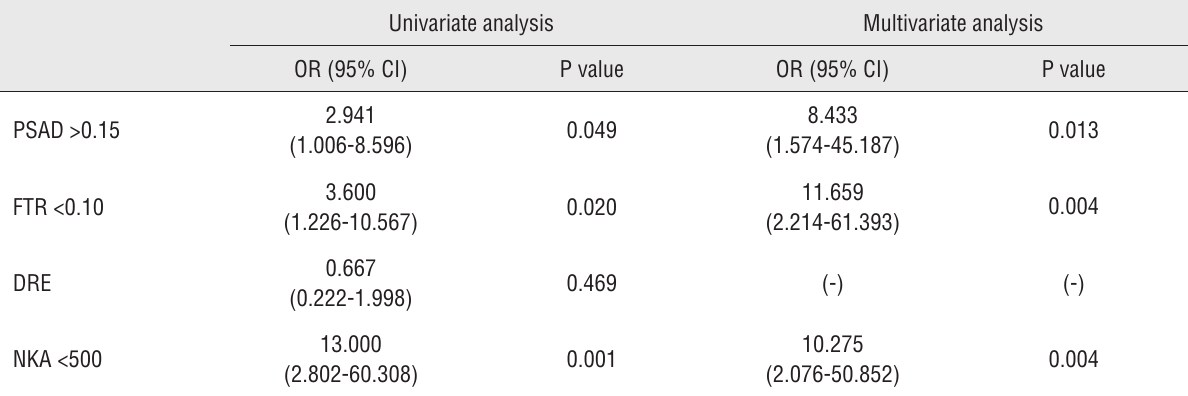
Table 5 - Univariate and multivariate analyses for the association of covariates with high risk of prostate cancer. Univariate analysis Multivariate